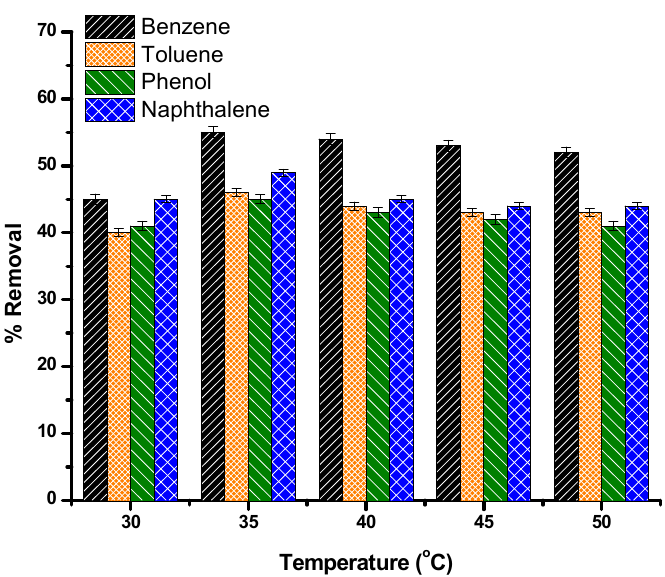
Figure 5. Effect of temperature on the removal of HCs from model wastewater using AC (60 min, adsorbent dose 600 mg/100 mL model wastewater).